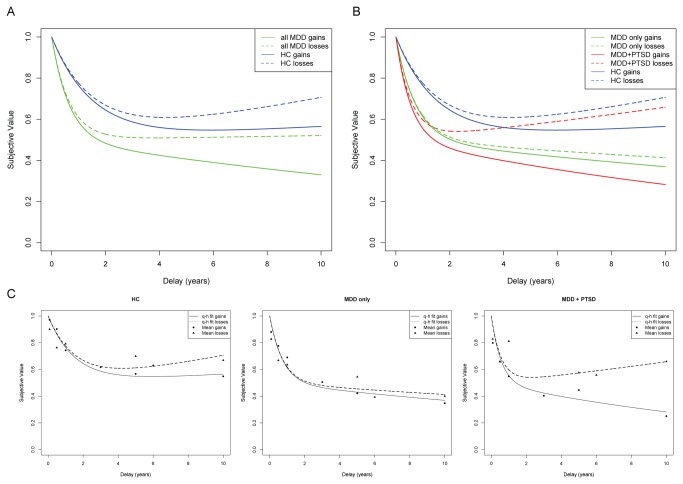
Quasi-hyperbolic discounting functions across groups.HC: Healthy controls; MDD-only: Major depressive disorder without PTSD; MDD+PTSD: Primary posttraumatic stress disorder comorbid with major depressive disorder.Temporal discounting reflects a decrease in subjective value as the time to the outcome increases. Subjective value is shown in all figures as a fraction of the immediate outcome. (A) Steeper discounting slopes for all MDD subjects relative to HC were found for short-term and long-term gains, but not for long-term losses. (B) PTSD significantly modulates temporal discounting over long-term losses, as demonstrated via significant differences in the slope for later losses between MDD only and MDD+PTSD subjects. (C) To illustrate model fits for each group, quasi-hyperbolic discounting functions are shown for each group separately together with means of subjective values obtained from the bisection method.